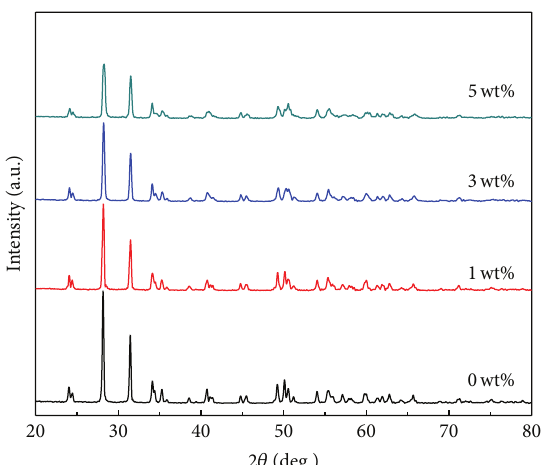
Figure 1: XRD patterns of the microwave sintered ZrO 2 samples with addition of 0, 1, 3, and 5 wt% TiO 2 contents.